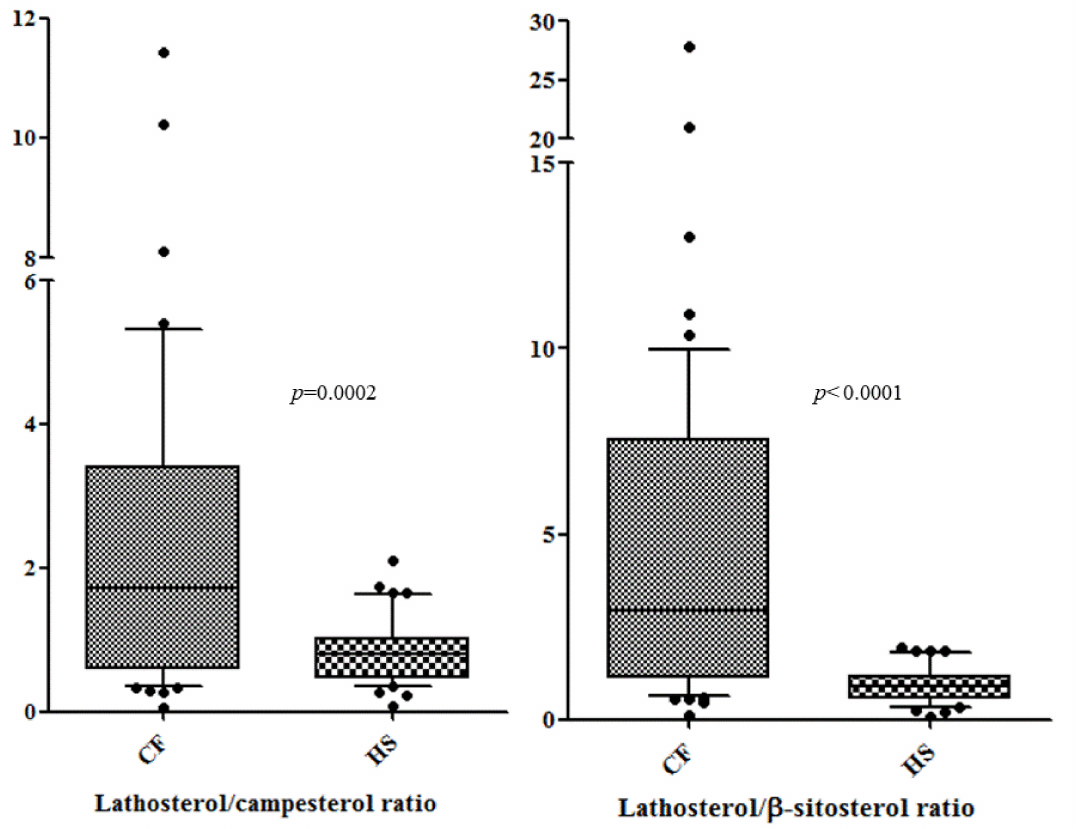
Figure 1. Lathosterol/campesterol and lathosterol/ β -sitosterol ratios in cystic fibrosis (CF) patients and healthy subjects (HS). Box and whiskers: 10 th –90 th percentiles and 1 st –3 rd quartiles are